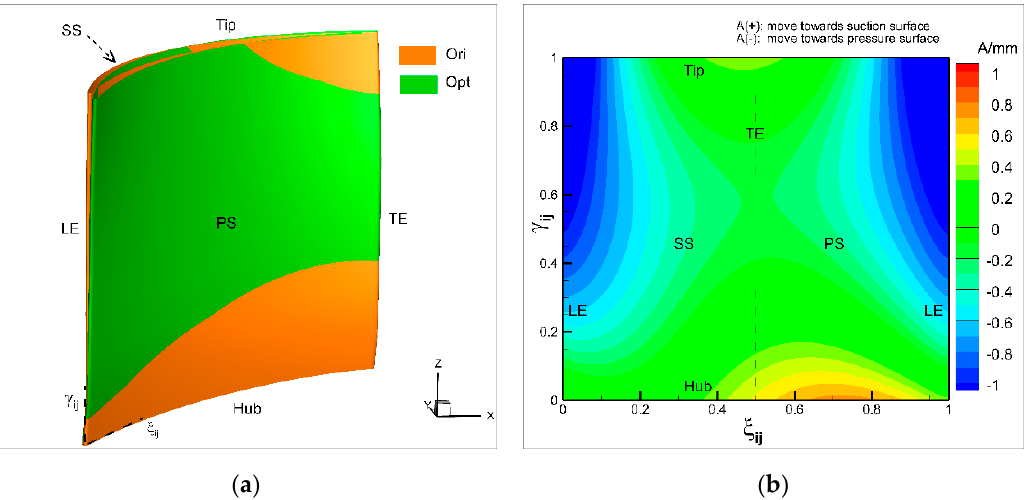
Figure 11. Comparison of suction and pressure surface of the original and optimized second-stage stator. ( a ) Three-dimensional modeling diagram of the original second-stage stator and the optimized second-stage stator; ( b ) the circumferential fluctuation amount A of the optimized second-stage stator compared with the original second-stage stator.